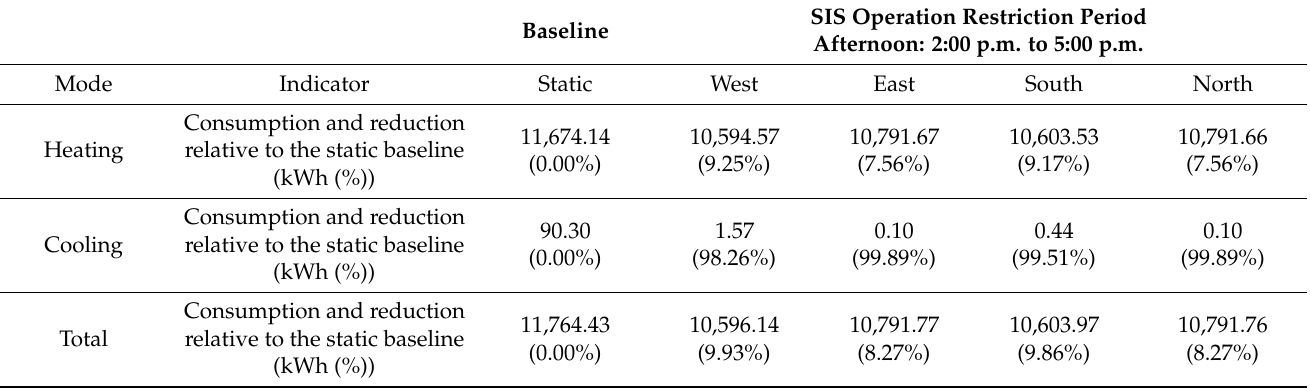
Table 14. Comparison of annual space heating and cooling energy consumption when a single window of the prototypical detached house model is forced open during the afternoon.